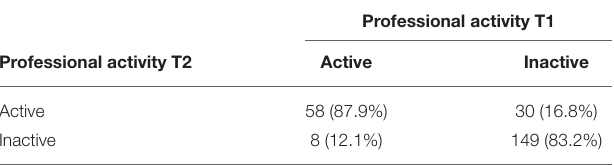
TABLE 3 | Professional activity at T1 and